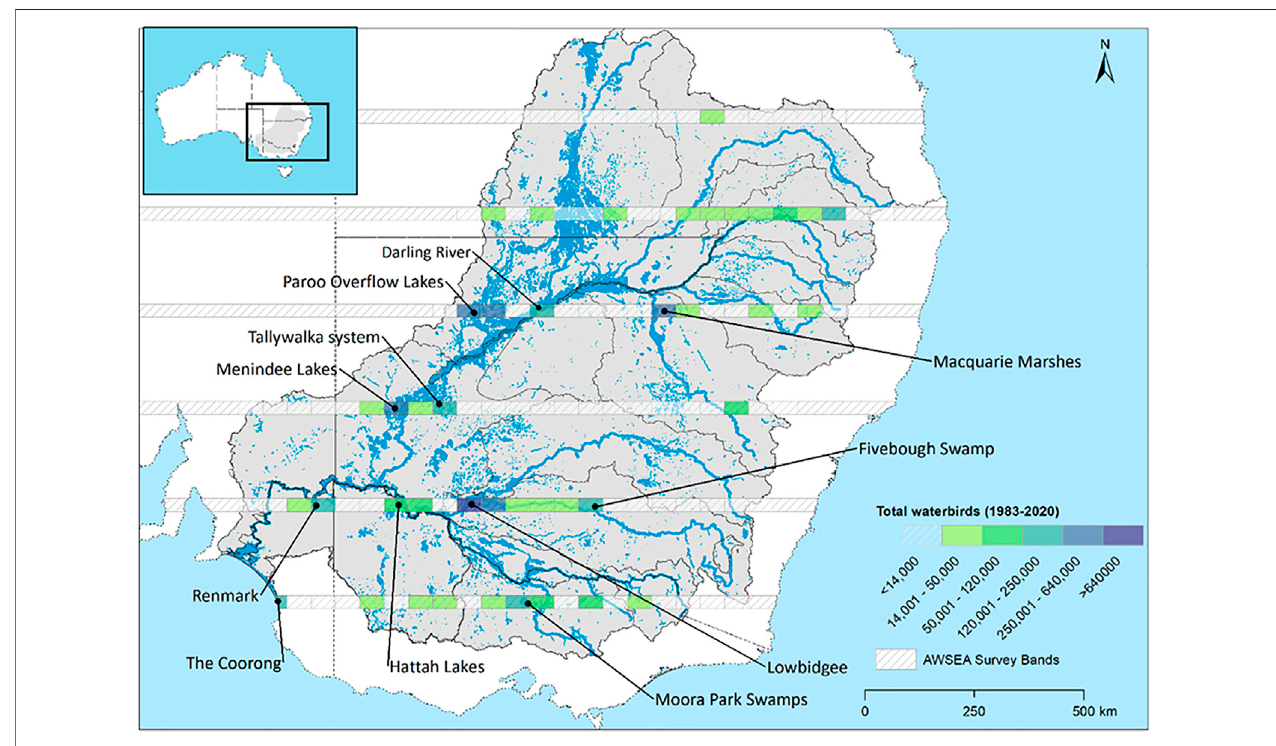
FIGURE 1 | The Murray – Darling Basin, Water Resource Planning Areas (outlines, Supplementary Appendix S1 for labels), six of ten survey bands of the Aerial Survey of Waterbirds in Eastern Australia intersecting with the Basin (hatched and shaded summary of totals 1983 – 2020 as 30 × 50 km grid cells), and labelled wetland complexes supporting high waterbird abundance (1983 – 2020) which intersected with the survey